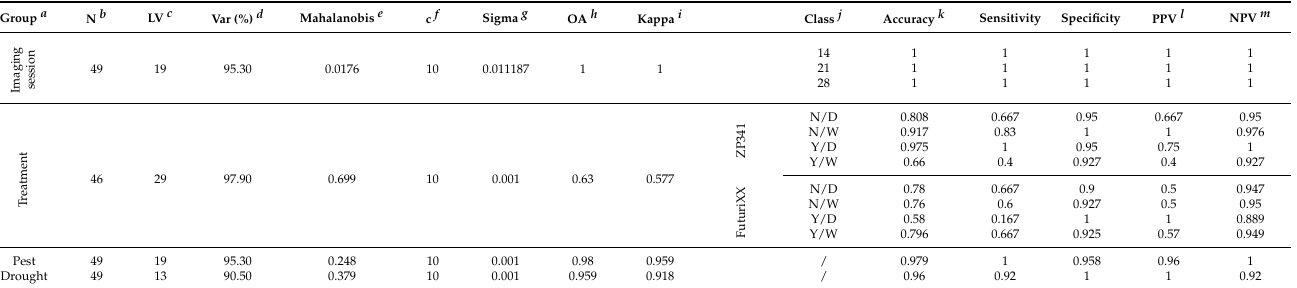
a Group: classification group (identification of imaging session, all treatments, pest infestation and drought stress); b N: number of samples in the test set; c LV: number of selected latent variables; d Var: cumulative explained variance of the selected LVs; e maximum/centroids/Mahalanobis: distance measures for